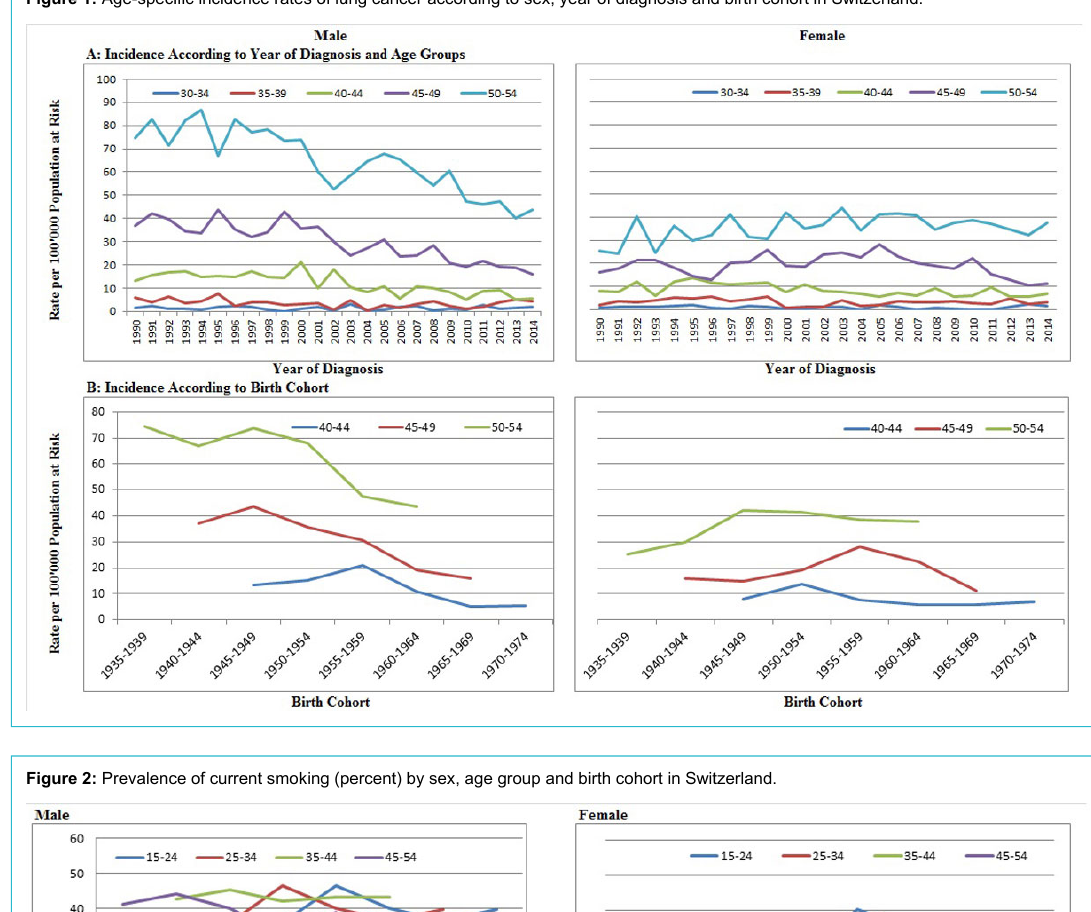
Figure 1: Age-specific incidence rates of lung cancer according to sex, year of diagnosis and birth cohort in Switzerland.